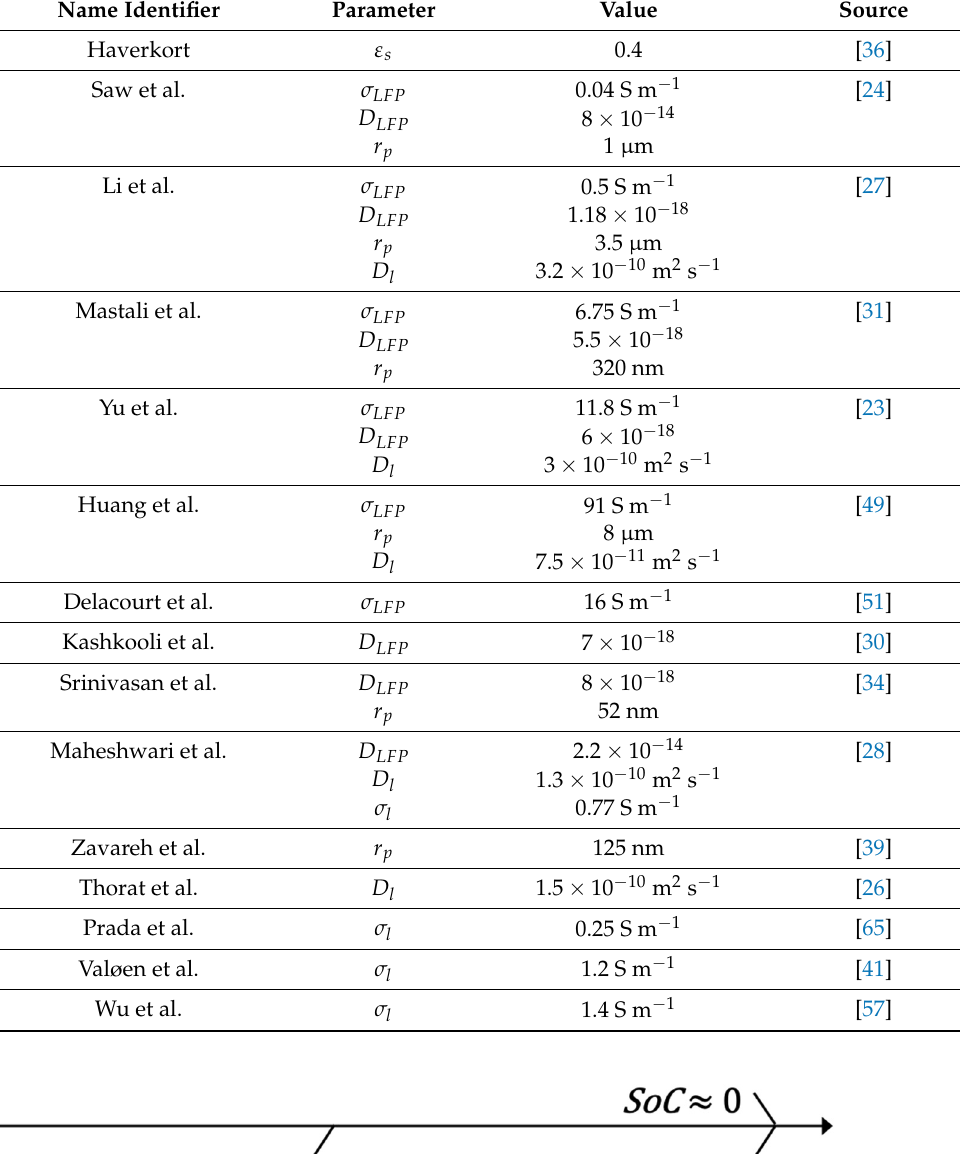
Table A1. Simulation parameters and name identifier related to the literature values.